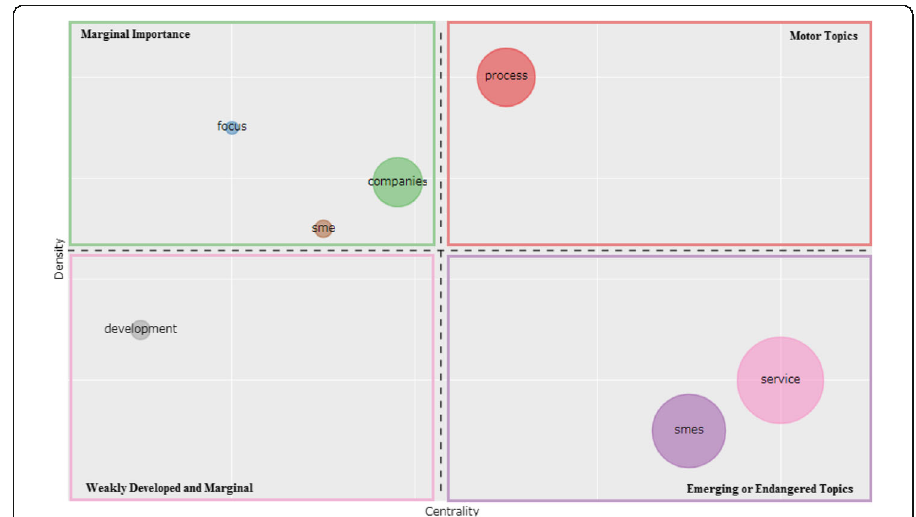
Fig. 10 Strategic diagram of research